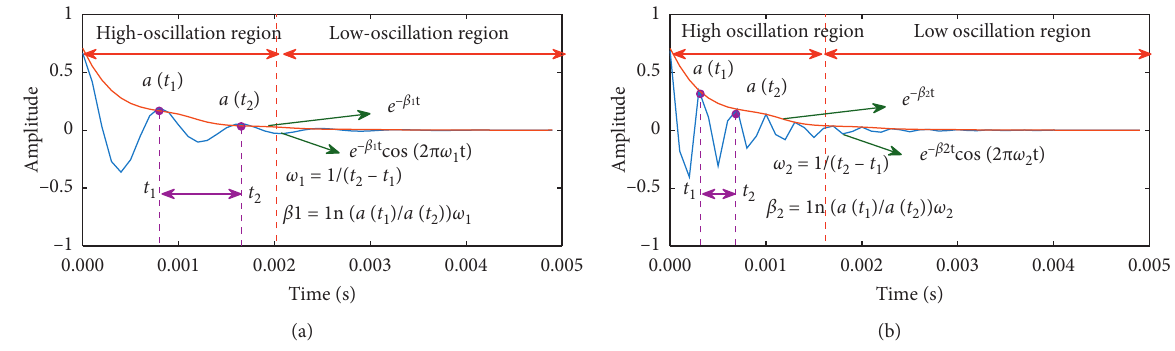
Figure 7: (a) The shock response in signal s